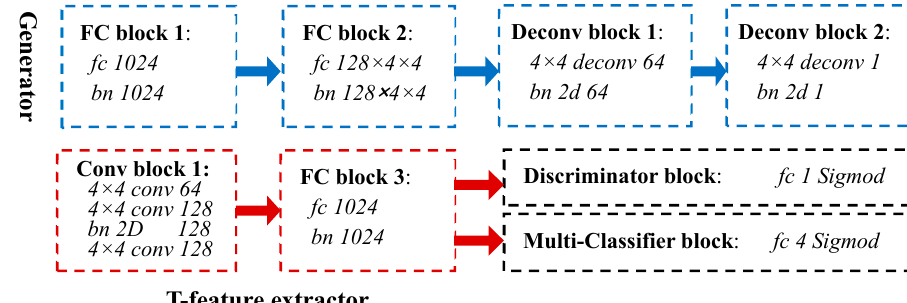
Figure 4. The parameters of TCGAN. The generator (blue rectangles) is composed of FC block 1, FC block 2, deconv block 1, and deconv block 2. The T-feature extractor (red rectangles) consists of the convolution block 1 and the fully-connected block 3. The Discriminator block and Multi-Classifier block are both implemented by a fully-connected layer.